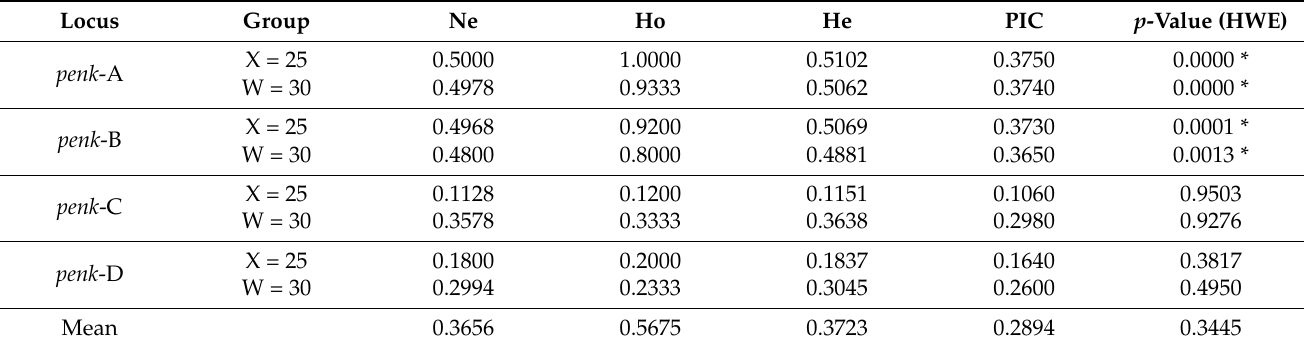
Figure 3. The sequencing peak chart of different genotypes of SNP loci in the penk gene of mandarin fish in group X ( n = 25) and of fish in group W ( n = 30). The sequencing peak of the homozygous SNP loci is a single peak with a higher peak, and that of the heterozygous SNP loci is a double peak with a lower peak. ( A ) penk -A, ( B ) penk -B, ( C ) penk -C, and ( D ) penk -D. Table 3. Diversity parameters of SNP loci in the penk gene of mandarin